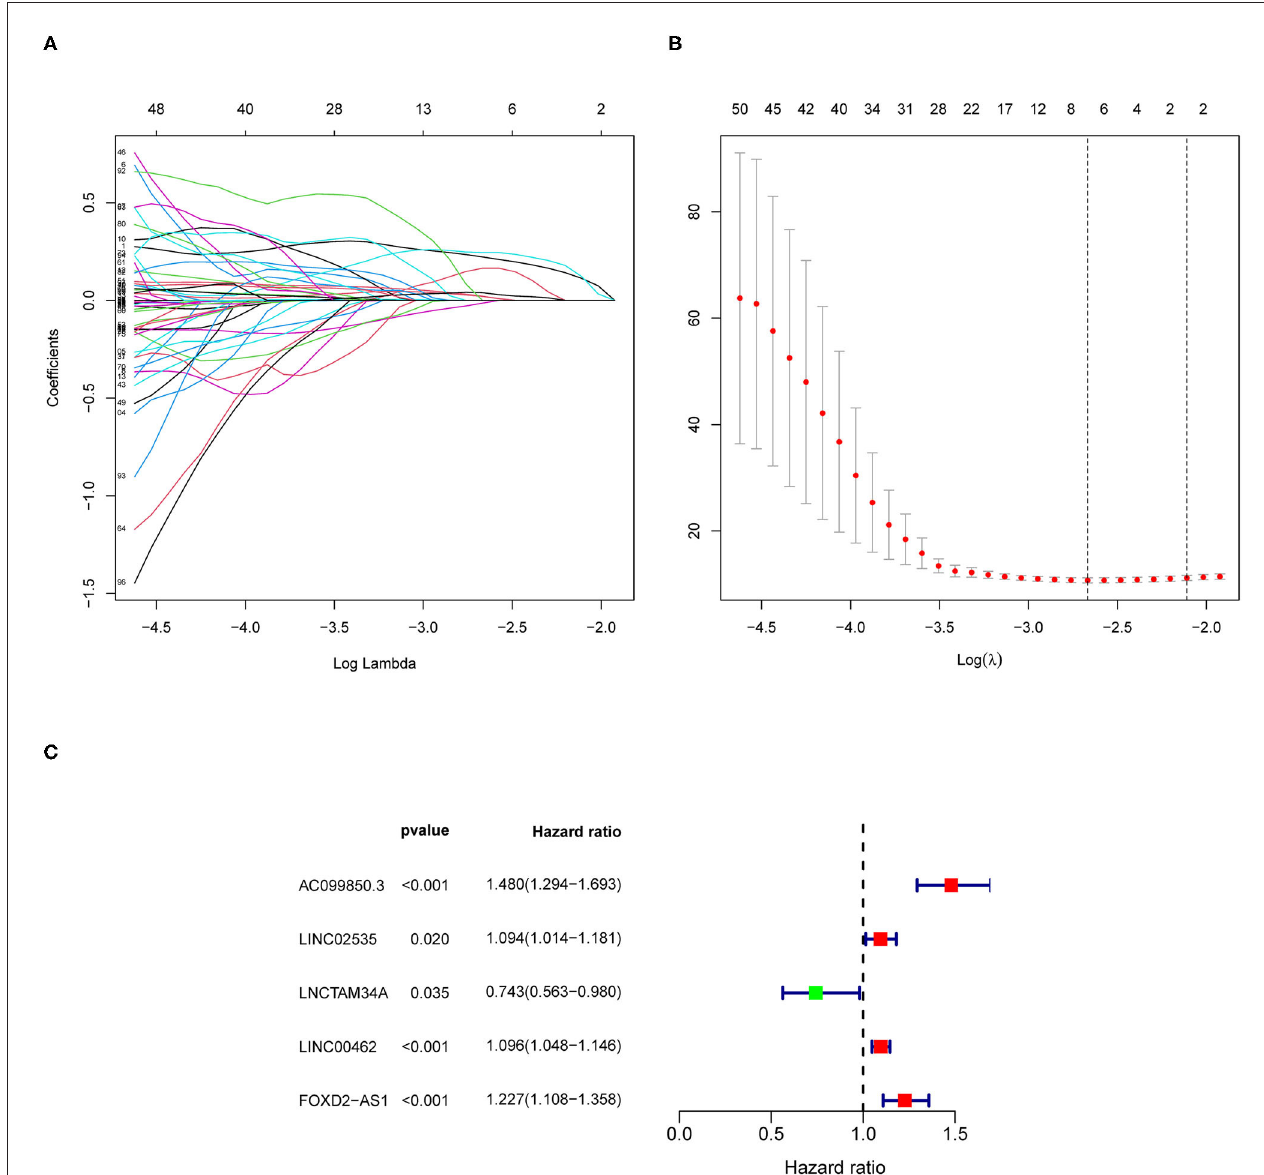
FIGURE 2 | The construction of the ferroptosis-related long non-coding RNAs (lncRNAs) prognostic risk model. (A,B) Lasso Cox regression analyses for the ferroptosis-based lncRNAs according to the results of univariate Cox regression analysis. (C) Multivariate Cox regression analysis for the ferroptosis-associated